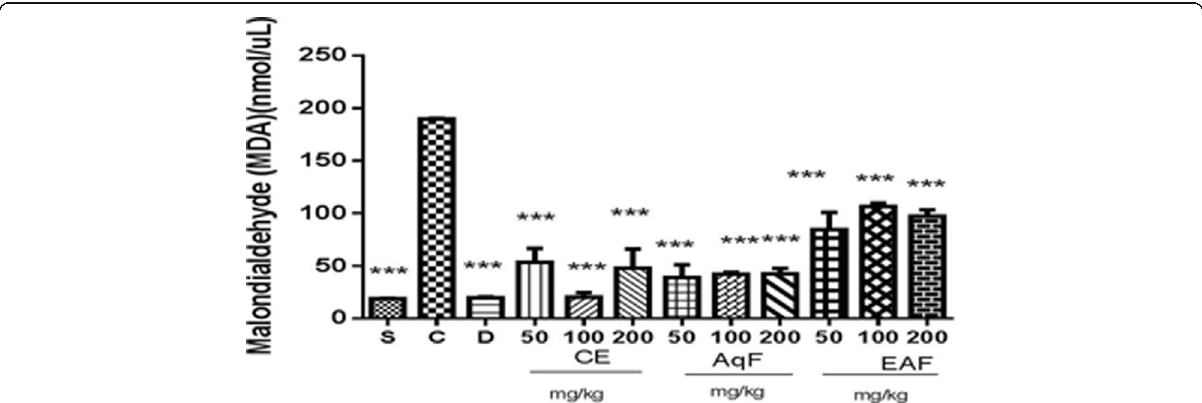
Fig. 5 The effects of the CE and fractions (50, 100 or 200 mg/kg) of E. uniflora Linn on MDA levels in a carrageenan-induced peritonitis model versus the carrageenan group. S (sham), C (carrageenan), D (diclofenac), CE (crude extract), AqF (aqueous fraction) and EAF (ethyl acetate-treated fraction). Data are expressed as the mean ± standard mean error ( n = 5). An ANOVA test was used to calculate statistical significance, * p < 0.05), *** p < 0.001 versus the positive control group. # indicates a significant difference between the groups treated with